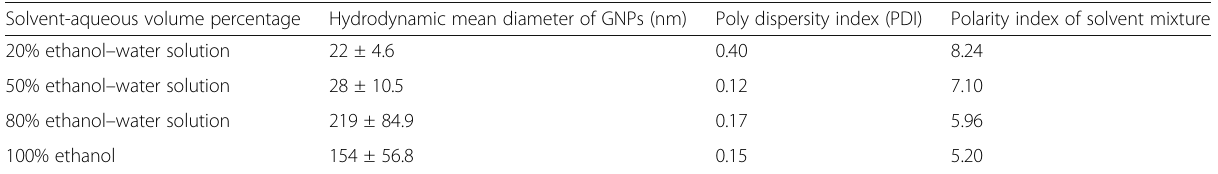
Table 1 Hydrodynamic mean diameter and PDI value GNPs in different volumetric percentage of ethanol obtained by DLS method and calculated polarity index of various ratio of organic solvent-water medium